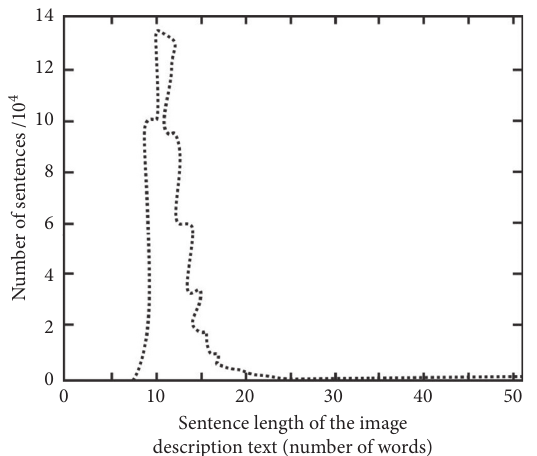
Figure 4: Distribution of the lengths of multimedia image description in the MSCOCO data